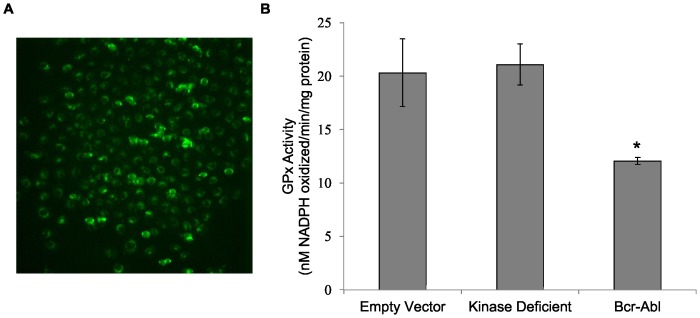
GPx-1 protein and activity levels are decreased by exogenous Bcr-Abl in MDA-MB-231.MDA-MB-231 cells transfected with a GFP-tagged Bcr-Abl vector and the transfection success was as assessed by fluorescence microscopy (A). The effect of ectopic Bcr-Abl expression on GPx enzyme activity in MDA-MB-231 cells. GPx activity was decreased 0.6-fold by ectopic expression of Bcr-Abl. Data shown is representative of one experiment. Two independent experiments were performed. * = P<0.001. Error bars indicate S.D.